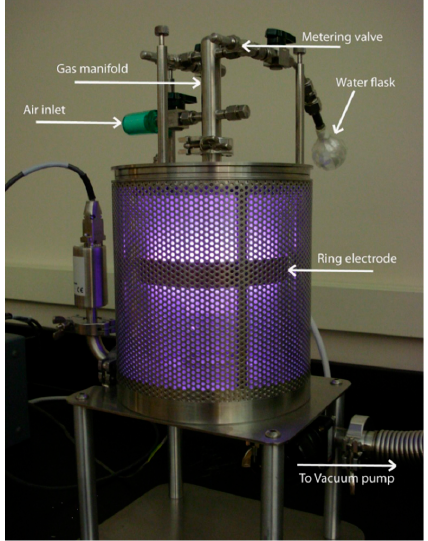
Figure 1. A glow-discharge water-vapor plasma (purple) produced in the reactor chamber of a plasma device under vacuum (~19.99 Pa) with a radio frequency signal of 135 kHz at 150 W.